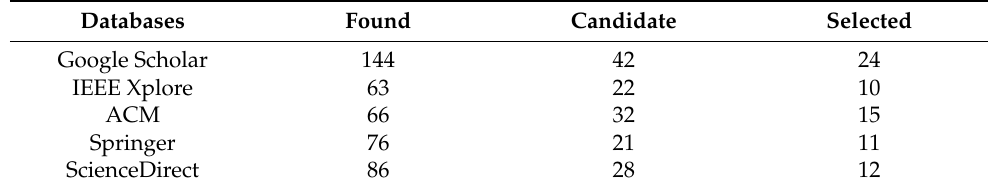
Table 1. Research articles and